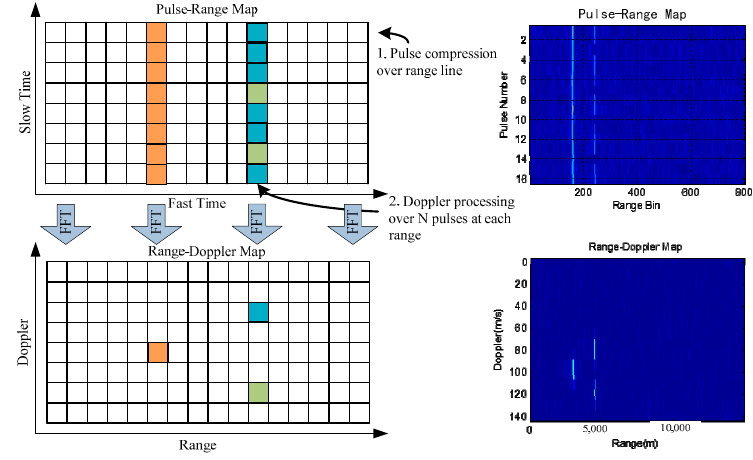
Figure 22. Schematic diagram of a pulse compression and Doppler processing.